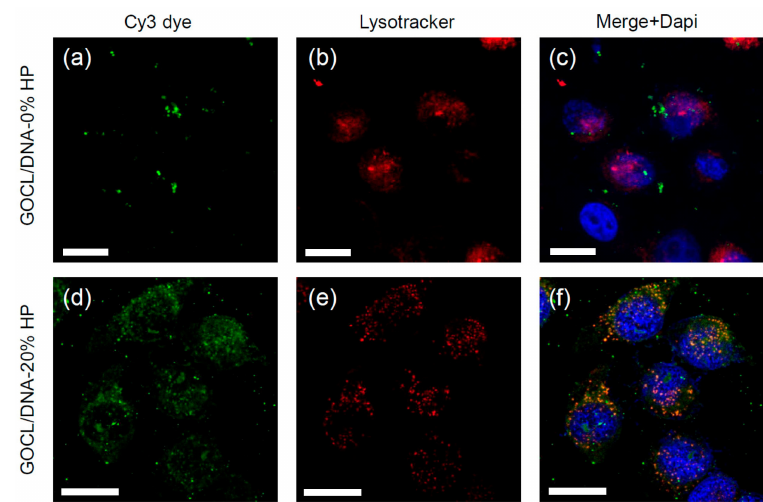
Figure 5. Representative confocal microscopy images of of MDA-MB cells treated with fluorescently labelled (green) pristine (panels a – c ) and biocoronated grapholipoplexes (HP = 20%) (panels d – f ). Cells were stained with LysoTracker Deep Red (red), a well-known lysosomal marker, and Dapi to stain the nuclei. Scale bars are 5